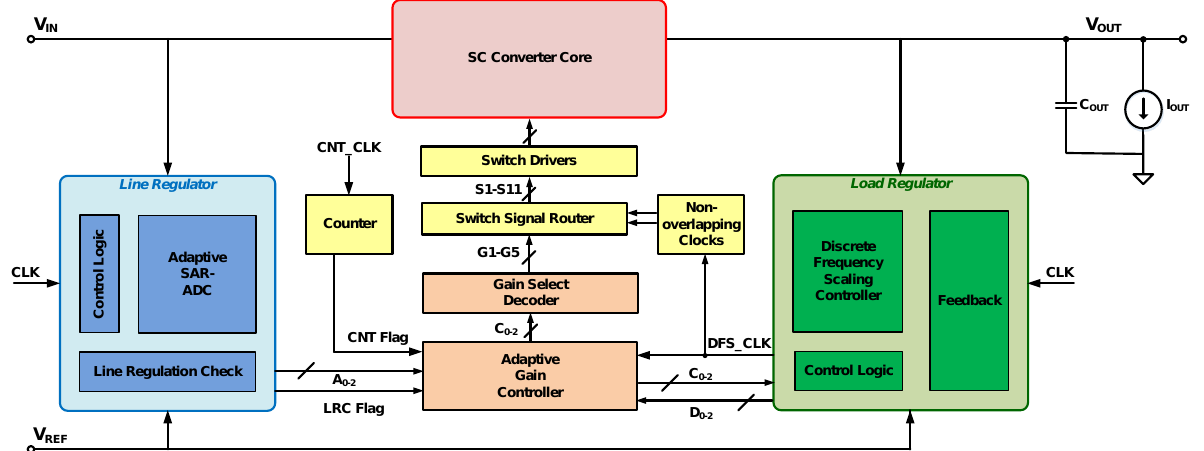
Figure 2. Architecture of the reconfigurable SC DC-DC converter system